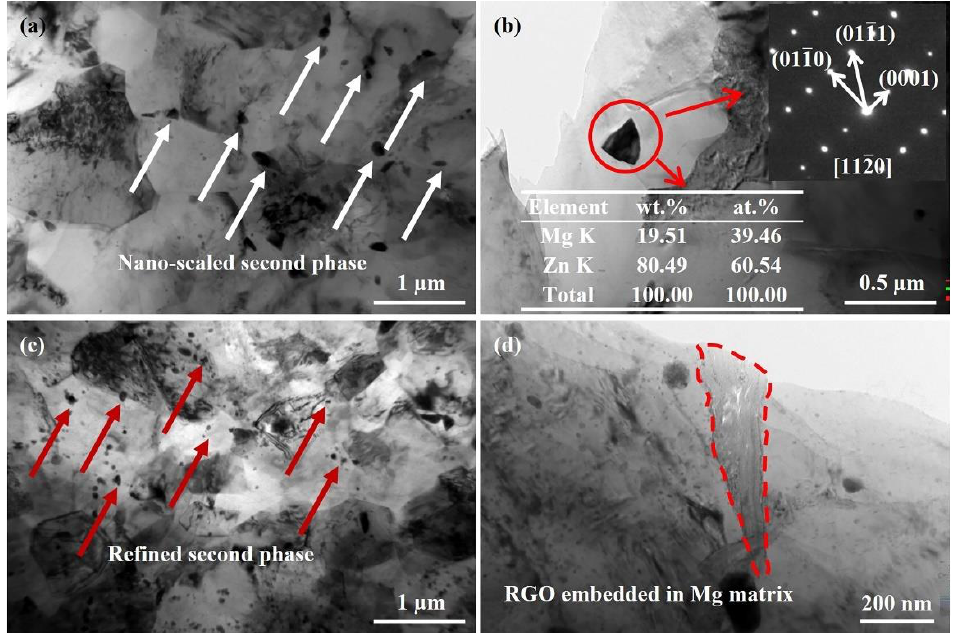
Figure 8. TEM micrographs of ( a , b ) ZK61 alloy and ( c , d ) 0.6 wt.% RGO/ZK61 composite.